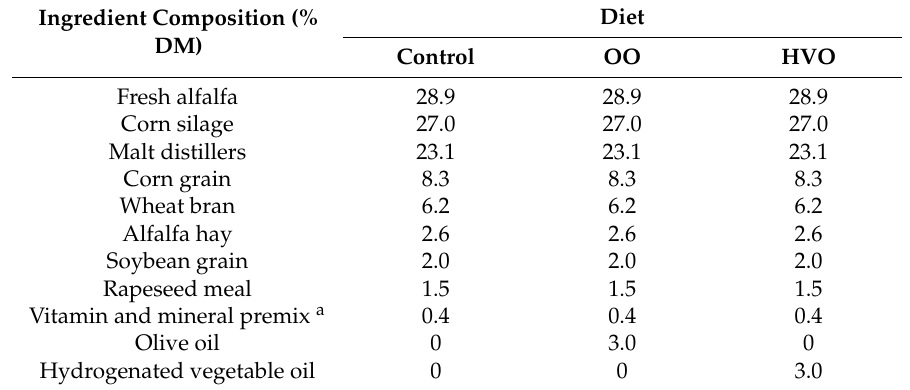
Table 1. Ingredients of control, olive oil (OO), and hydrogenated vegetable oil (HVO) dietary treatments. Diet Ingredient Composition (% DM) Control